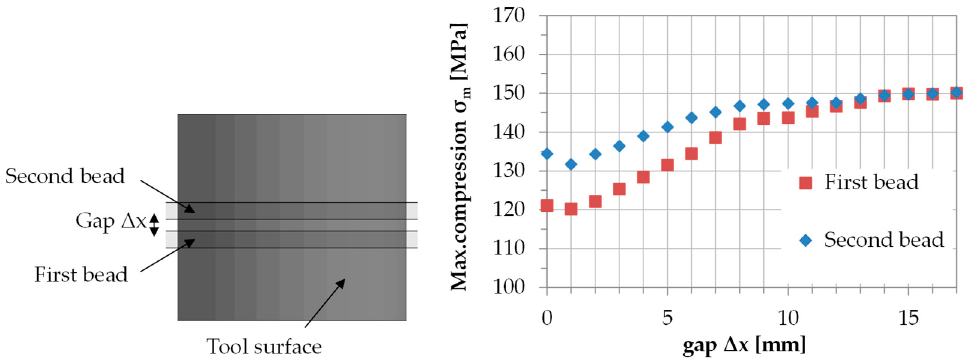
Figure 21. Influence of a gap between the two consecutive parallel weld beads (dimensions A3) on the maximum compressive stresses induced on the 100 mm diameter tool after cooling.